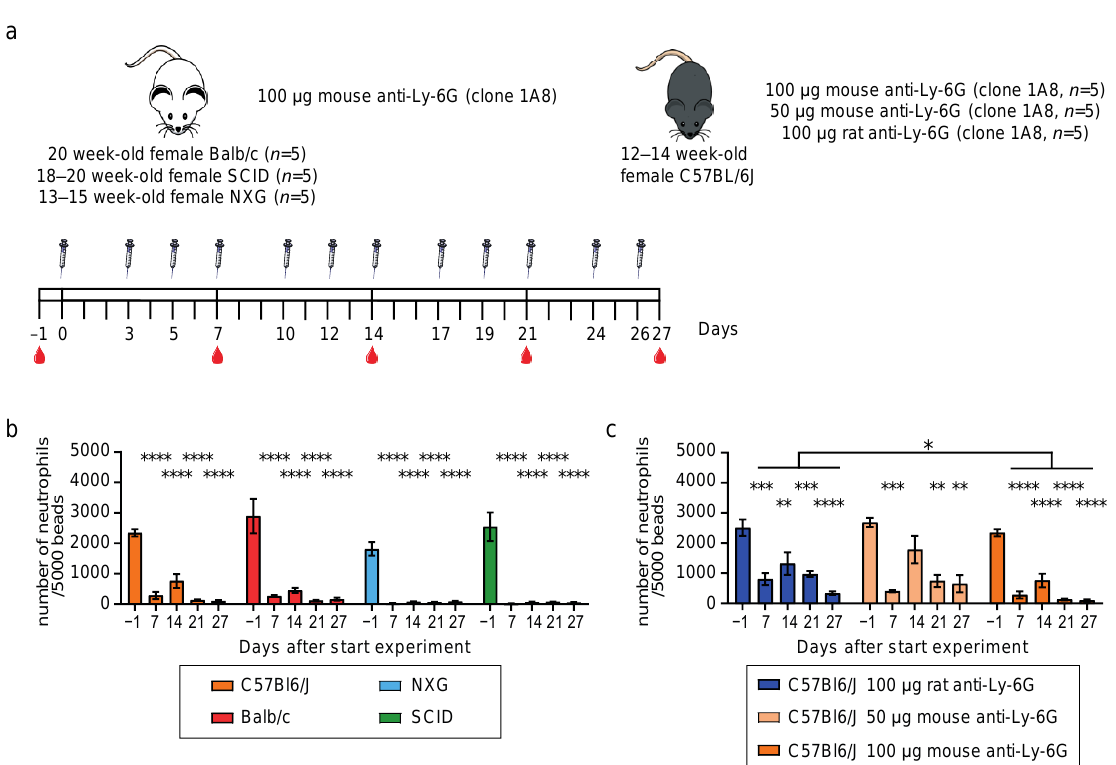
Figure 2. Mouse-Ly-6G efficiently depleted neutrophils in C57Bl6/J, Balb/c, NXG, and SCID mice. ( a ) Experimental set-up; i.p. injections with the depletion antibodies were performed three times a week for four weeks. Blood was drawn via cheek puncture once a week before injection with